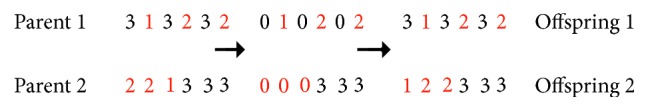
Operation crossing.